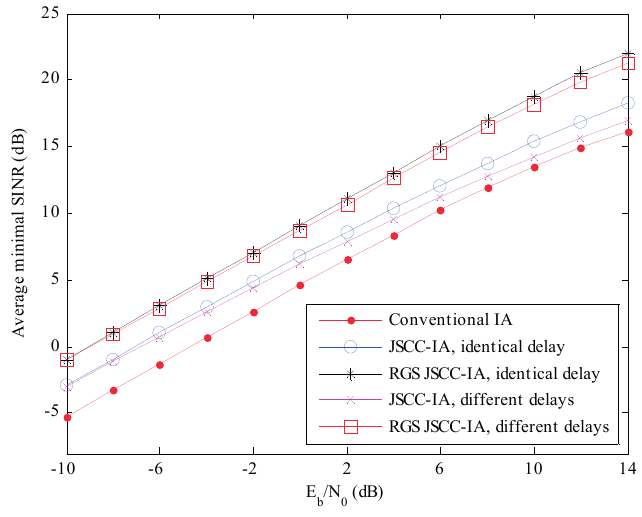
Figure 13. The average minimal received SINR of the conventional IA scheme, the JSCC-IA schemes with identical/different propagation delays and the RGS JSCC-IA